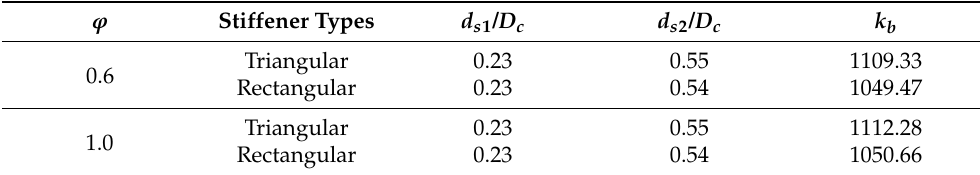
Table 3. Optimum results for the longitudinal stiffeners with closed cross-section types.